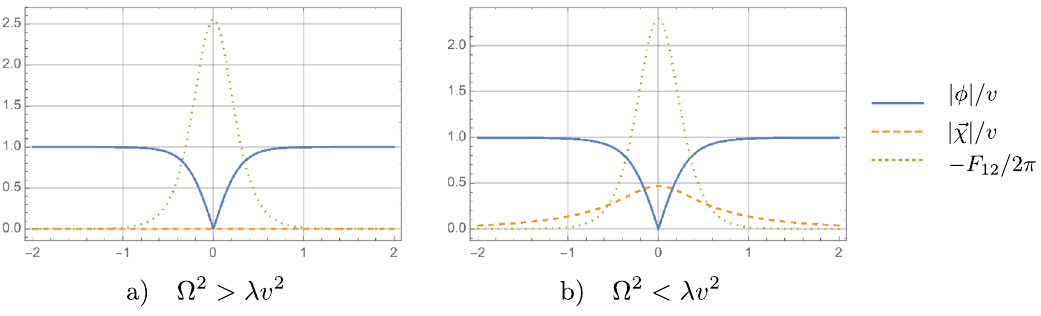
Figure 1 . The non-superconducting vortex (a) and the superconducting vortex (b). The parameter choice is ( e, λ, v ) = (2 , 2 , 2) with Ω = 3 for (a) and Ω = 1 for